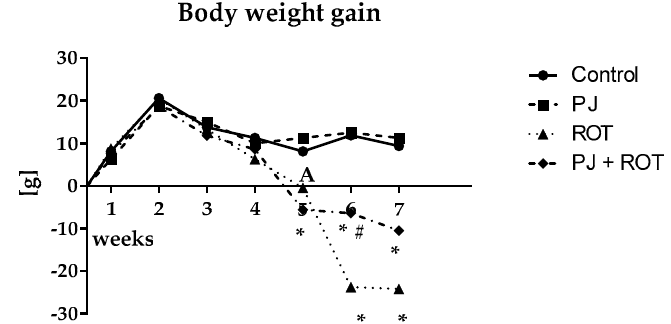
Figure 1. Effect of pomegranate juice treatment (PJ) on body weight gain of rats injected with rotenone (ROT). Data are presented as mean values of eight rats per group and analyzed using one-way analysis of variance (ANOVA) followed by Sidak’s multiple comparisons test. * p < 0.05 vs. Control. # p < 0.05 vs. ROT.